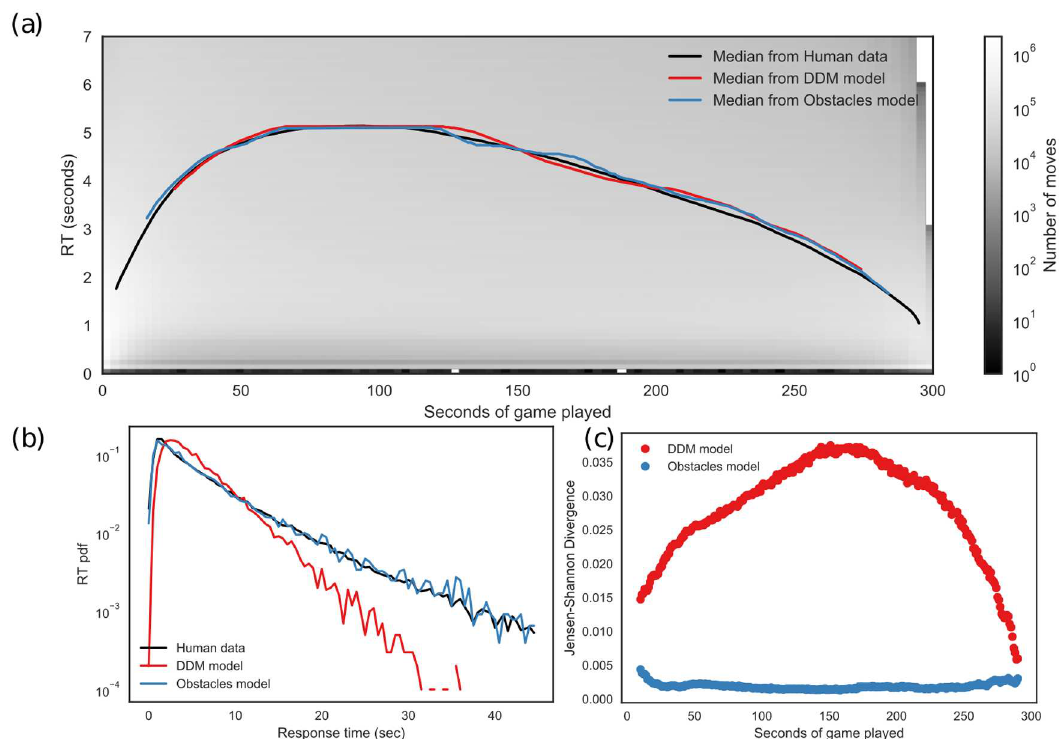
Fig 2. Response time statistics and fit for human players. a) 2-D histogram (in log scale) of RT of moves as a function of the seconds of game played. Lines show median RT for human statistics (black line) and best fit with no entropic barriers (red line) and obstacles model (blue line). No significant difference between distributions at every instant in both models, Kolmogorov-Smirnoff Test, KS statistic < 10 −4 , p > 0.99). b) RT distribution at 50% of the game (black trace). Model with obstacles (blue line) fits with extremely high precision in both short and long time scales (Kolmogorov-Smirnoff statistics D best fit for the DDM (Kolmogorov-Smirnoff statistics, D n = 0.754, p < 10 −6 )). c) Goodness of fit indicated by Jensen-Shannon divergence. Model without obstacles (red dots) shows significantly higher values than proposed obstacles model (blue dots) at every instant of the